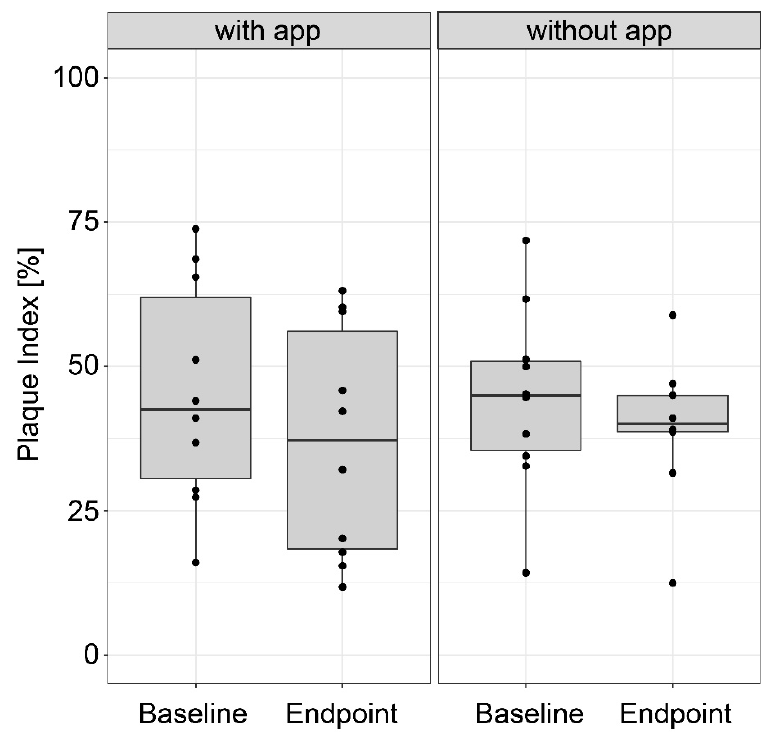
Figure 1. Box plot representations of the plaque index in the group that cleaned with the app and the group that cleaned without the app (n = 10 per group), at the start and the end of the study, respectively.